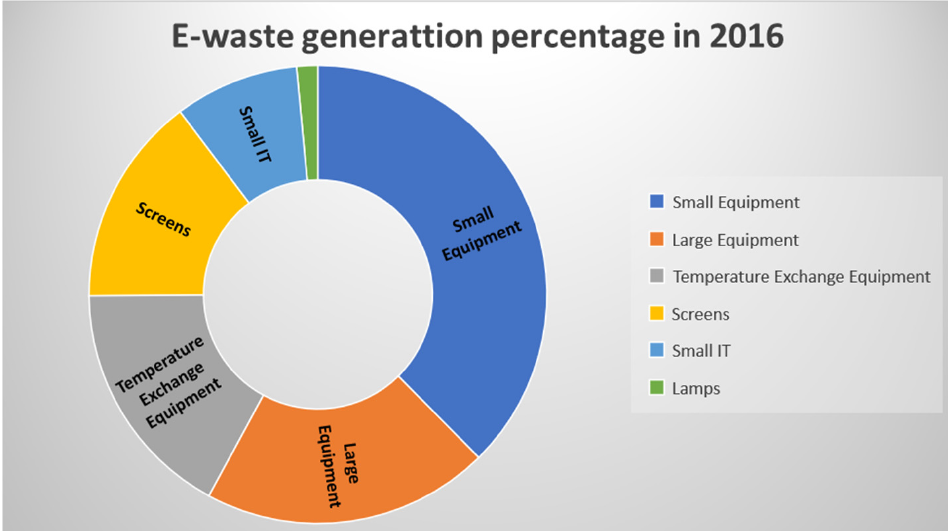
Figure 1. The major e-waste sources and their approximate percentages in 2016.